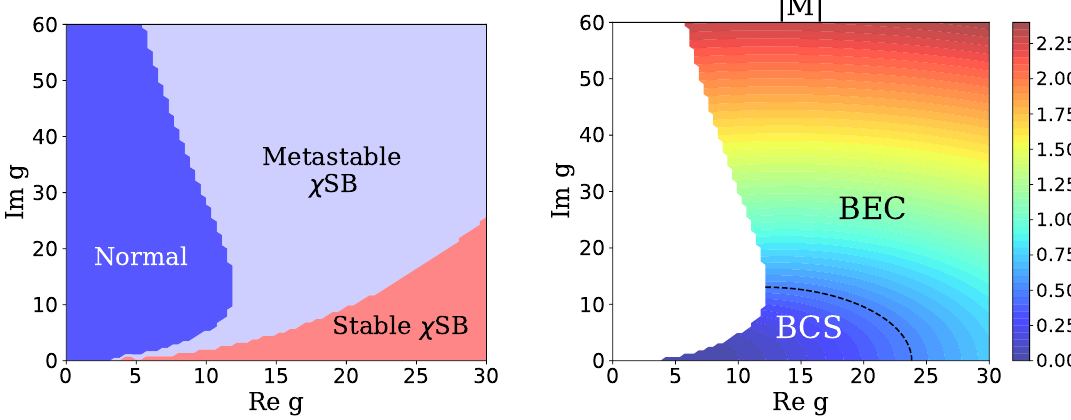
Figure 7. Same as figure 4 but with a smooth UV regularization using the form factor (5.1). Note that the vertical scale is twice larger than figure